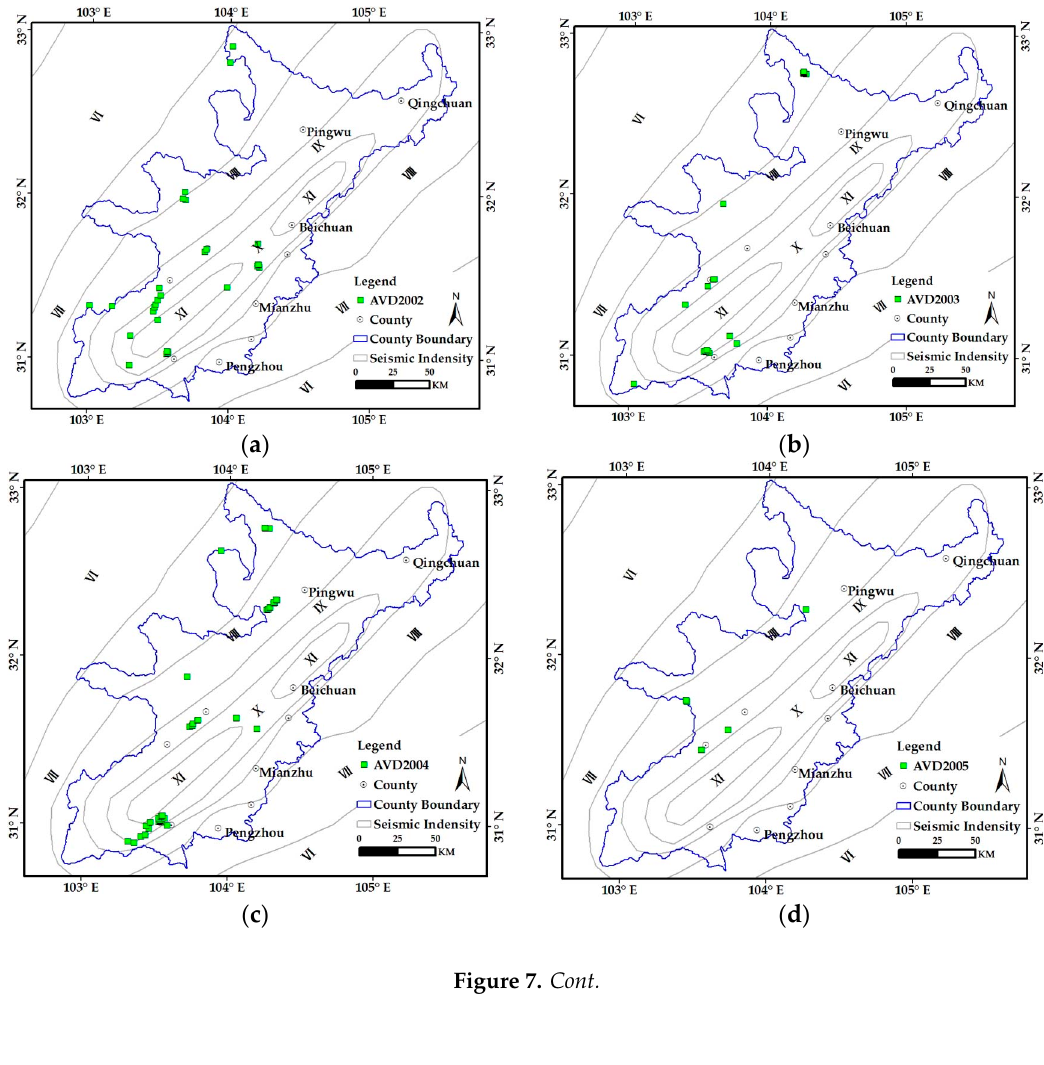
Table 1. Area affected by vegetation damage (AVD) of the study